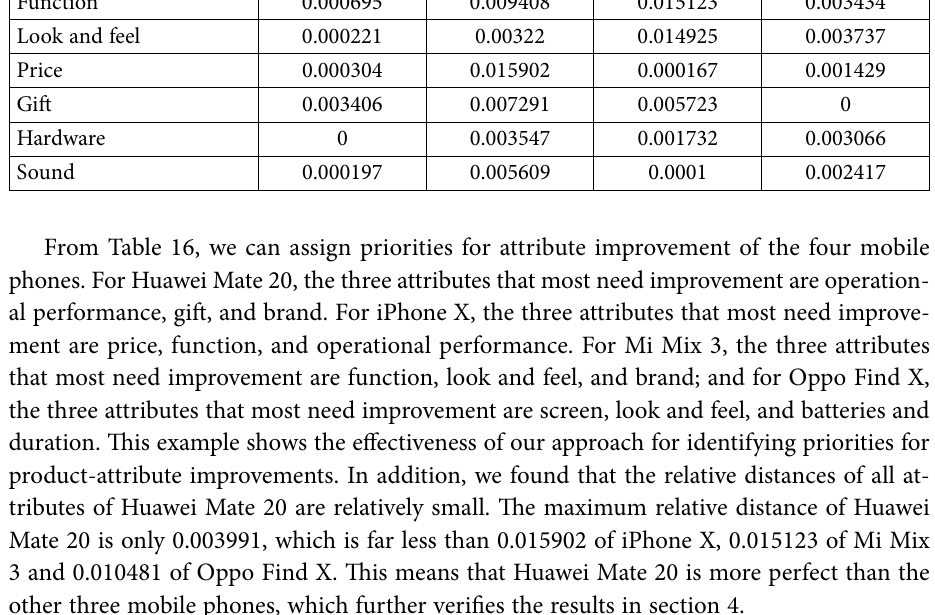
positive ideal solution